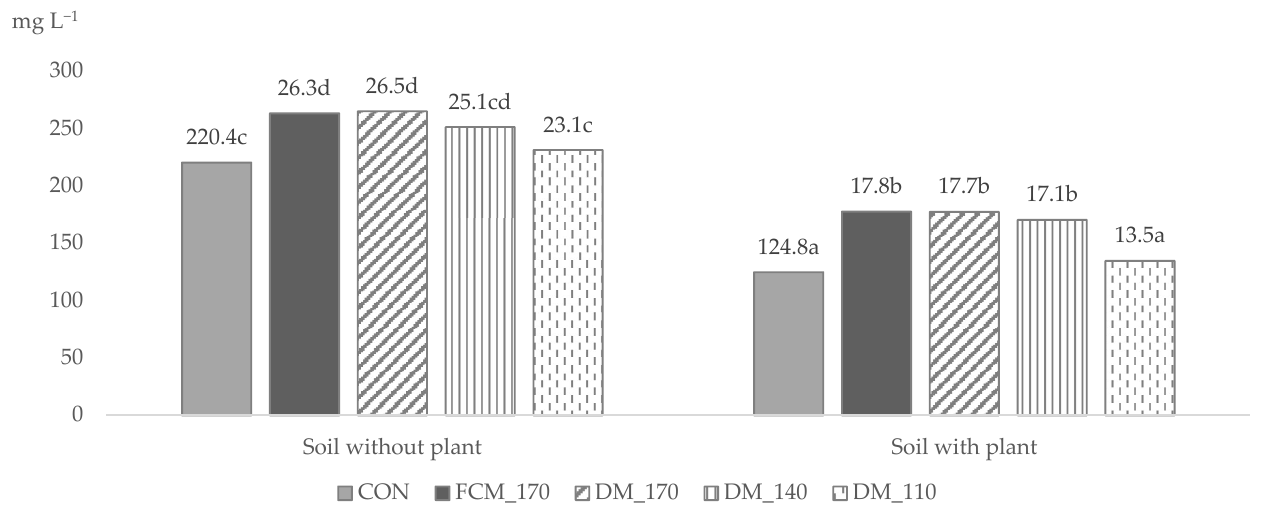
Figure 4. The effect of digestate from liquid cow manure on NO 3 -N in soil leachate. CON—control, FCM_170—Liquid cow manure N 170 , DM_170—Digestate N 170 , DM_140—Digestate N 140 , DM_110— Digestate N 110 . Values followed by different letters are significantly different ( p ≤ 0.05) based on Fisher’s LSD test.